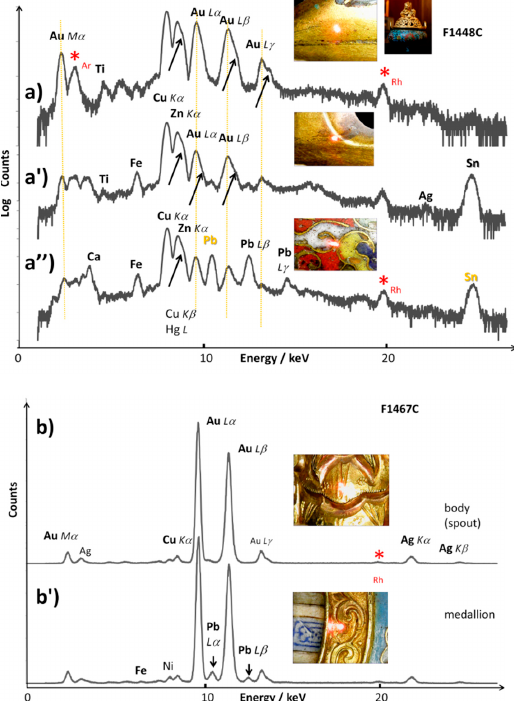
Figure 4. XRF spectra recorded on the metal parts of the incense burner ( a , a ′ , a ′′ ) and the ewer ( b , b ′ ); the lightened spot on the photograph shows the analyzed area: ( a ) rim, ( a’ ) rim with gilding partially lost and ( a” ) cloison ; ( b ) spout and ( b (cid:48) ) medallion rim. Main XRF peaks are labelled; arrows indicate the contribution of Hg L peaks in the spectra a, a (cid:48) and a”. Red stars (*) indicate the contribution of the instrument (Rh peaks). The logarithmic scale on the top spectra makes more visible the contribution of minor